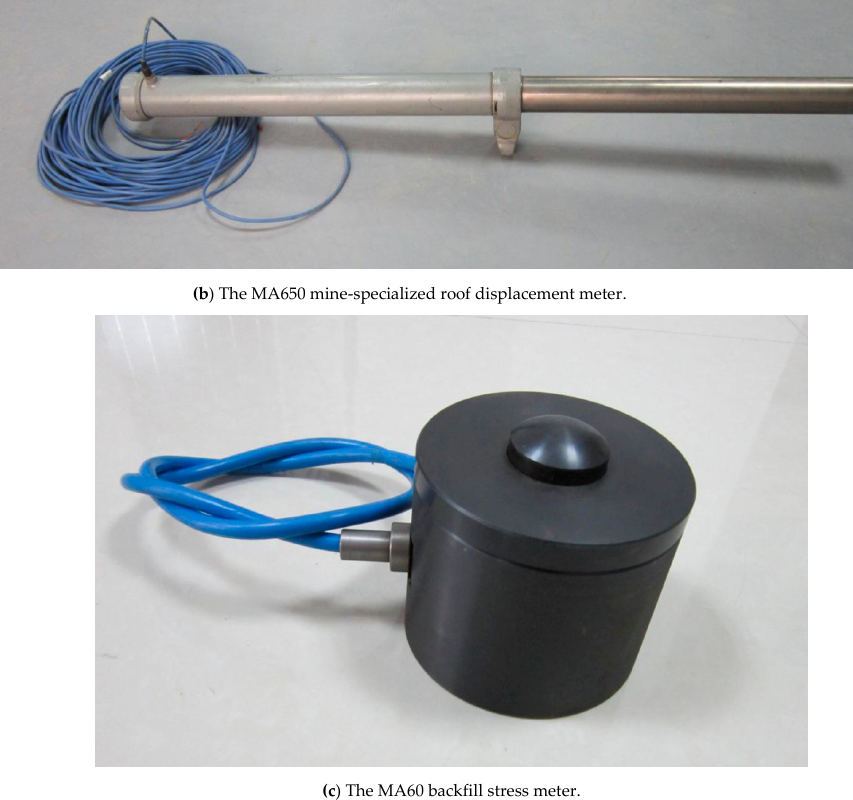
Figure 8. The ground pressure monitoring sensor in backfill mining.